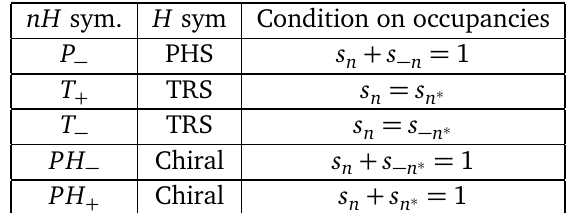
Table 3: Summary of how the different non-Hermitian symmetries of the Hamilto- nian can induce the standard Atland-Zirnbauer [ 78 ] symmetries on the right entan- glement Hamiltonian. The first column lists the non-Hermitian symmetry, the sec- ond column indicates the induced Hermitian symmetry, and in the last column, we present the required conditions on the many-body state (expressed in the occupancy of the different eigenmodes of the initial Hamiltonian). It is interesting to note that the pseudo Hermitian symmetry PH − (resp. PH + ) requires that the spectrum has no purely imaginary (resp. real) eigenvalues in the absence of spectrum degeneracies. nH sym. H sym Condition on occupancies + s = 1 P − PHS s − n n = s T + TRS s n n ∗ T − TRS PH −